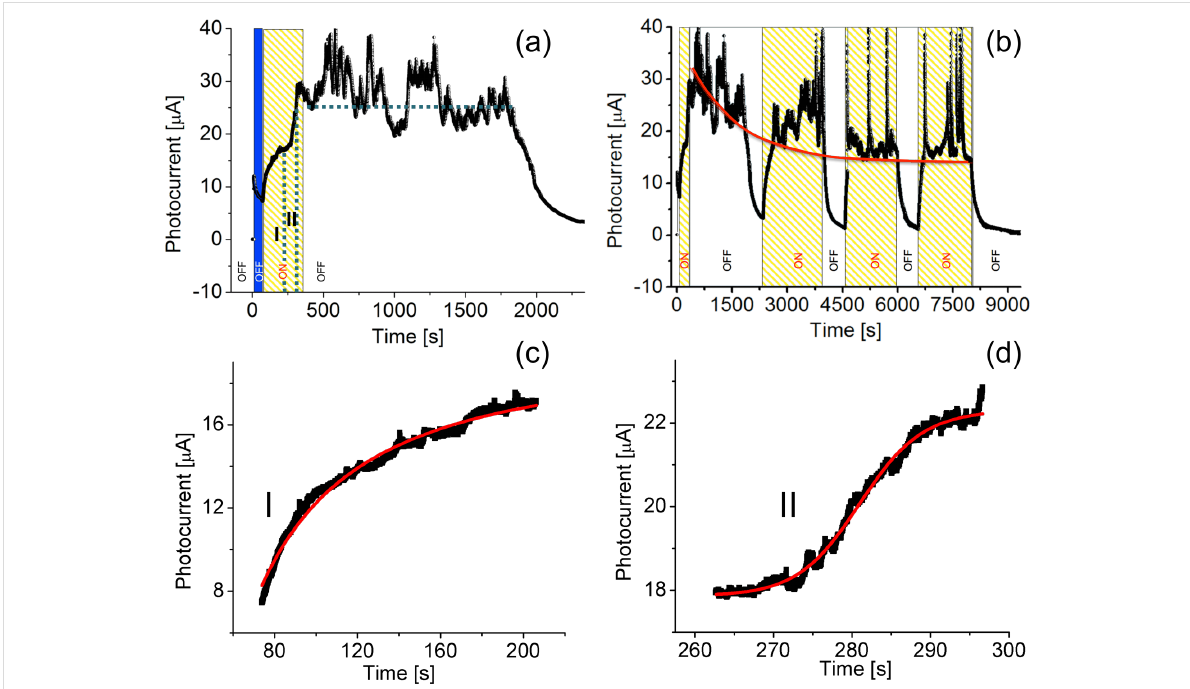
Figure 4: (a) Photocurrent rise and relaxation during the first cycle of the experiment. The bias of − 10 V was applied at 0 s, the blue shaded area indi- cates the initial dark current decay. After the illumination was switched on the photocurrent rose in two steps, which are separated on the figure by vertical dashed lines and marked as I and II. (b) Several cycles of the illumination; the sample bias is − 10 V, the source of illumination is a 150 W Xe lamp (white-light source). The periods under illumination are marked by the yellow shaded areas. (c), (d) First two steps of the photocurrent increase, marked as I and II in (a), fitted by Equation 2 (red